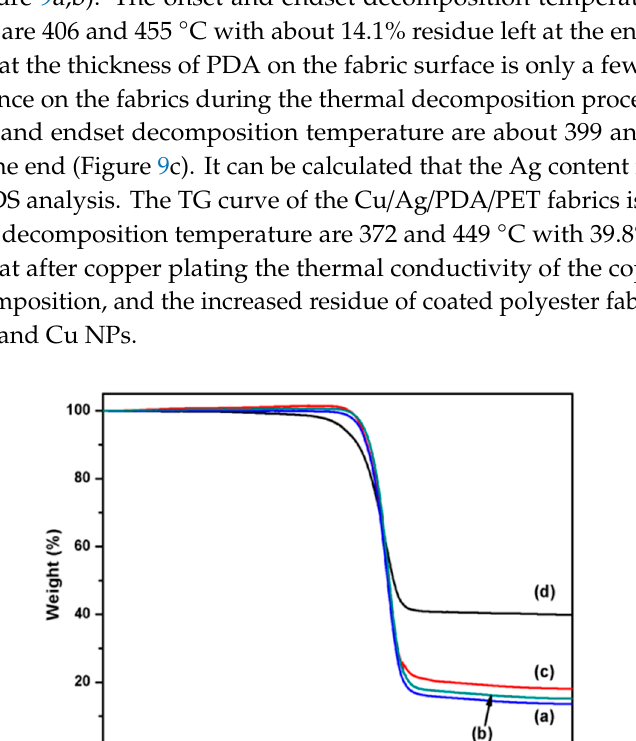
Figure 8. X-ray diffraction (XRD) patterns of ( a ) PET fabrics; ( b ) PDA/PET fabrics; ( c ) Ag/PDA/PET fabrics; and ( d ) Au/Ag/PDA/PET fabrics.